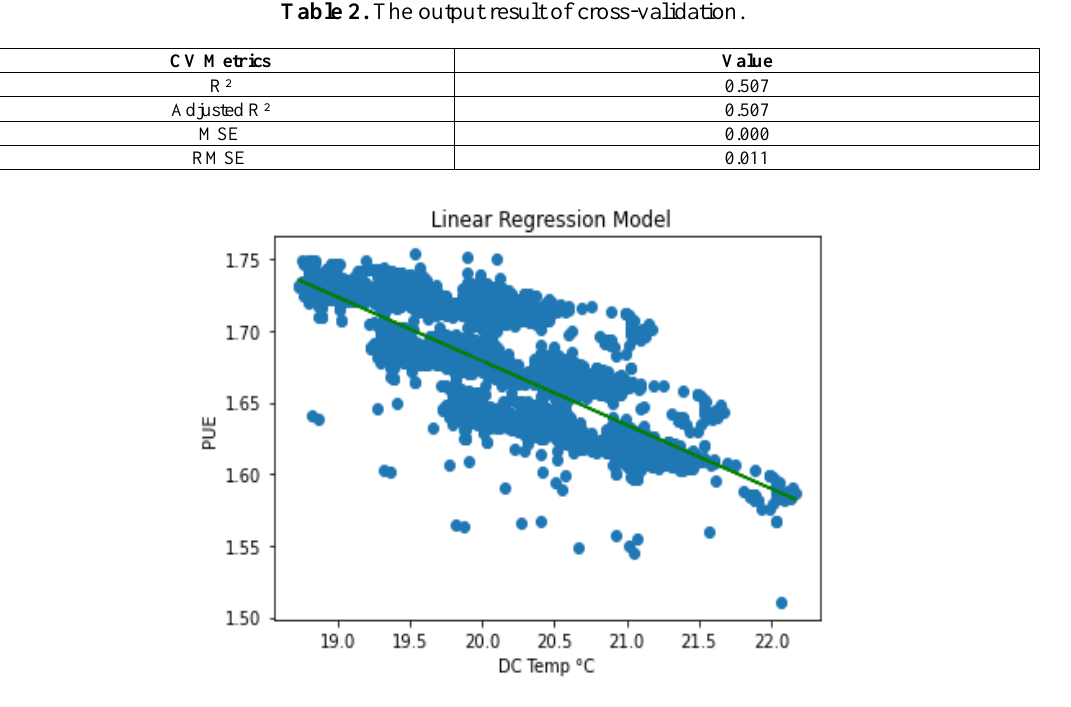
Figure 3. PUE vs DC temp- scatter plot.